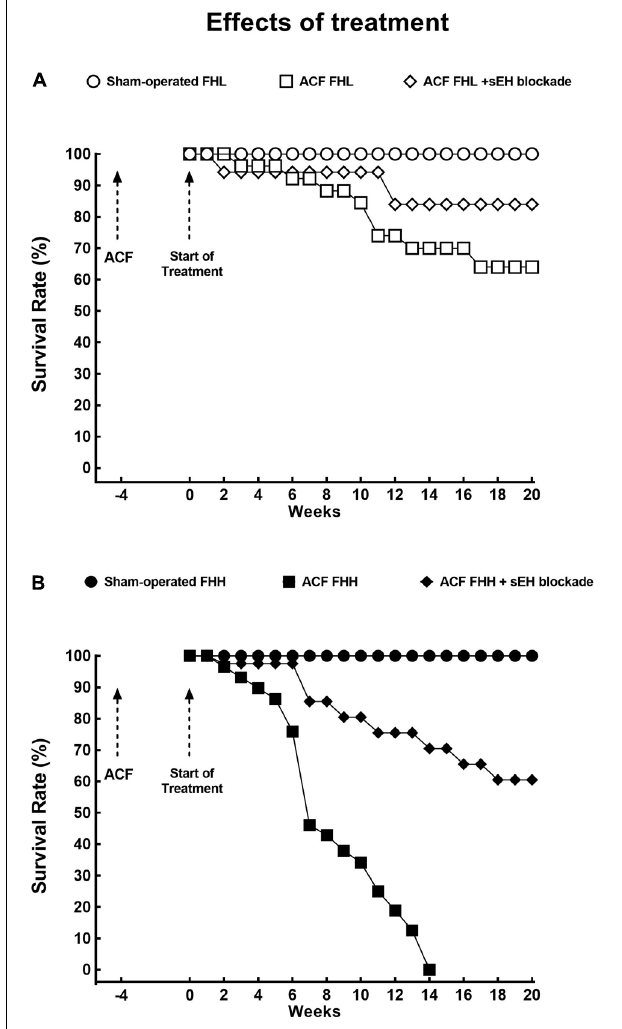
FIGURE 3 | (A) Survival rates in sham-operated fawn-hooded low-pressure rats (FHL) with ACF and ACF FHL rats treated with a soluble epoxide hydrolase (sEH) inhibitor. (B) Survival rates in sham-operated fawn-hooded hypertensive (FHH) rats, untreated ACF FHH, and ACF FHH treated with inhibitor of sEH. The comparison of the survival rates curves was performed by log-rank Mantel-Cox test followed by Gehan-Breslow-Wilcoxon test.